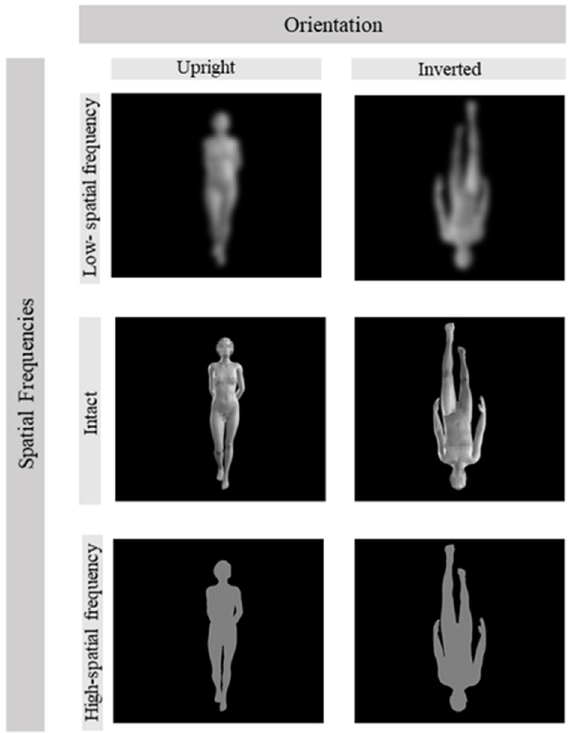
Figure 1. Examples of female and male virtual models used in the study as stimuli. The figure depicts the variation in orientation (upright vs. inverted) and spatial frequency (high spatial frequency, vs. intact images, and vs. low spatial frequency).